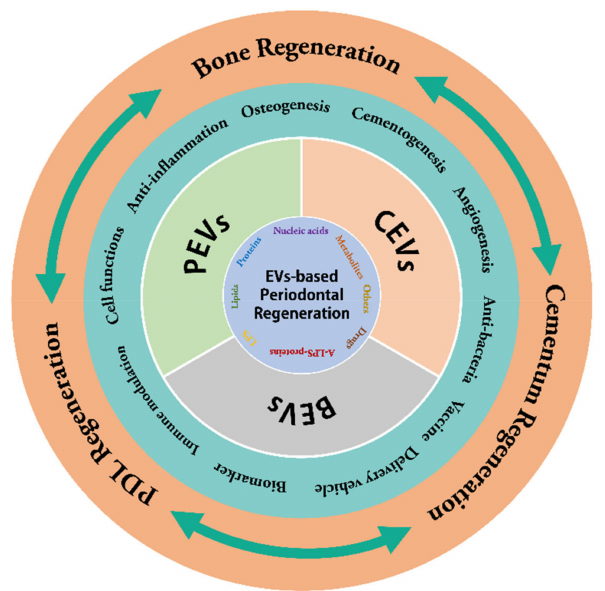
Figure 1. CEVs, BEVs and PEVs with versatile functions for periodontal regeneration. CEVs, eukaryocyte-derived extracellular vesicles; BEVs, bacterial-derived extracellular vesicles; PEVs, plant-derived extracellular